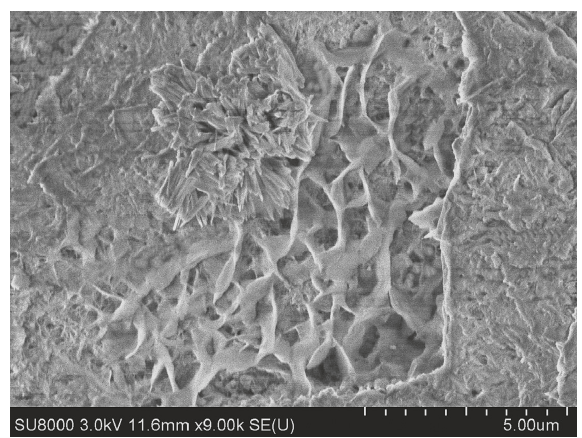
Figure 14: Micromorphology of cement stone LR2 (high